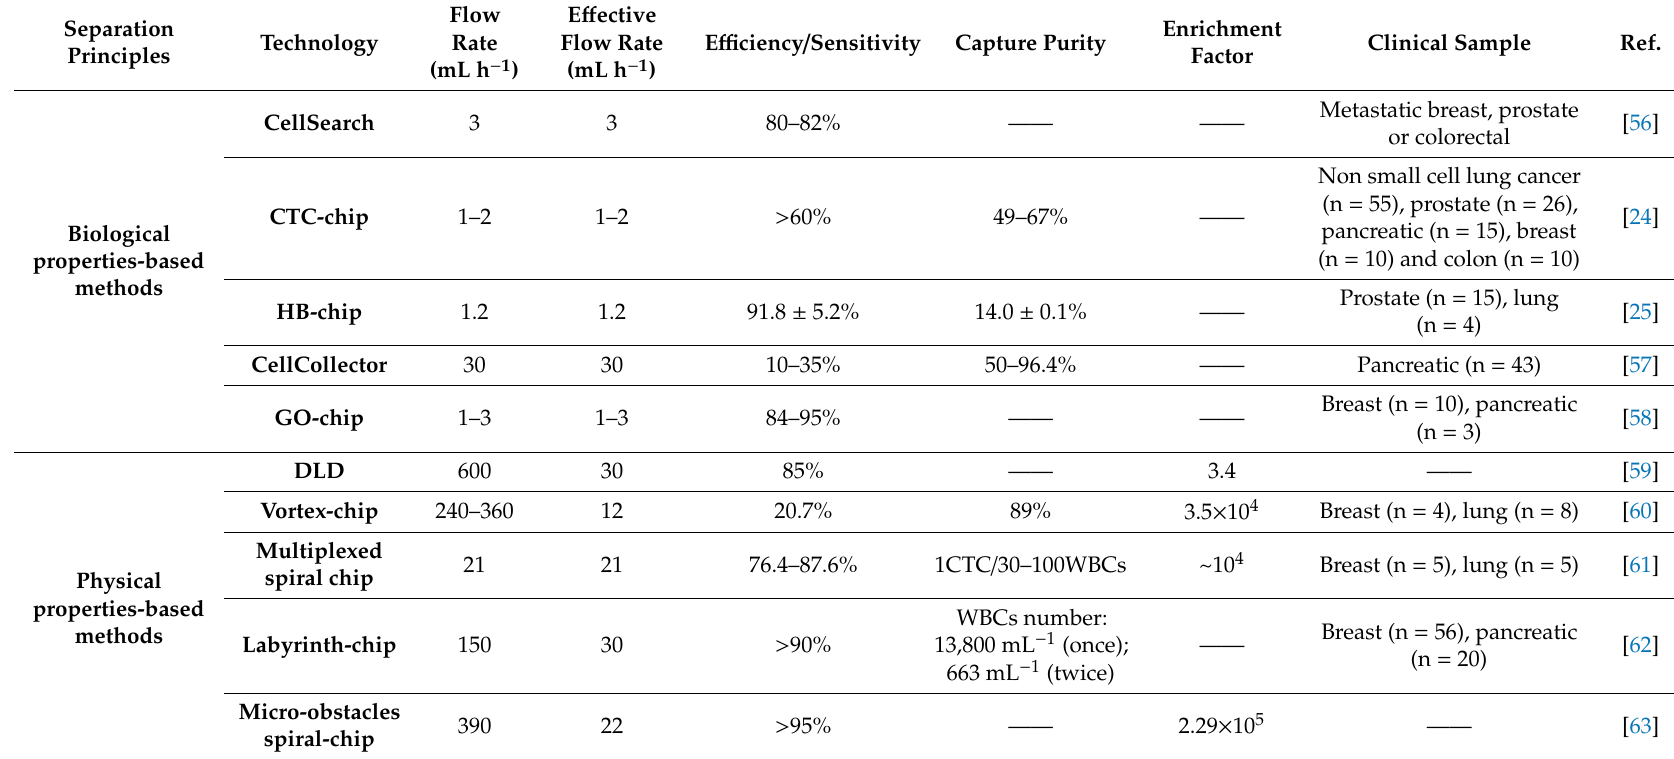
Table 1. Summary of biological and physical properties-based CTC detection